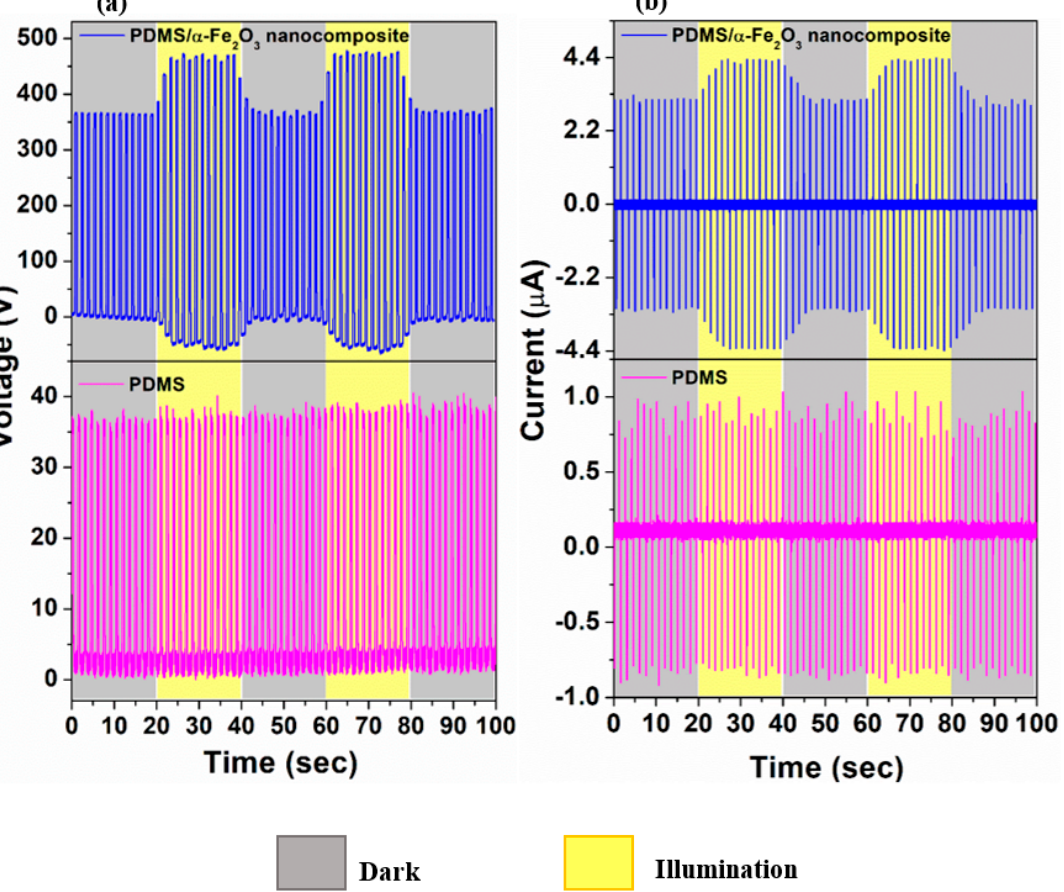
Figure 4. ( a ) Voltage and ( b ) current outputs of PDMS and PDMS/ α− Fe 2 O 3 nanocomposite − based TENGs in the dark and under illumination. TENGs in the dark and under